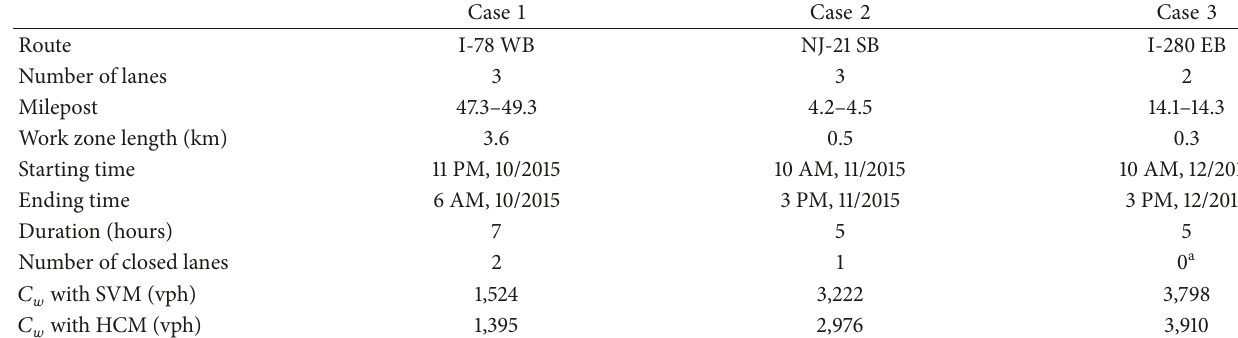
Table 2: Work zone characteristics of case studies.